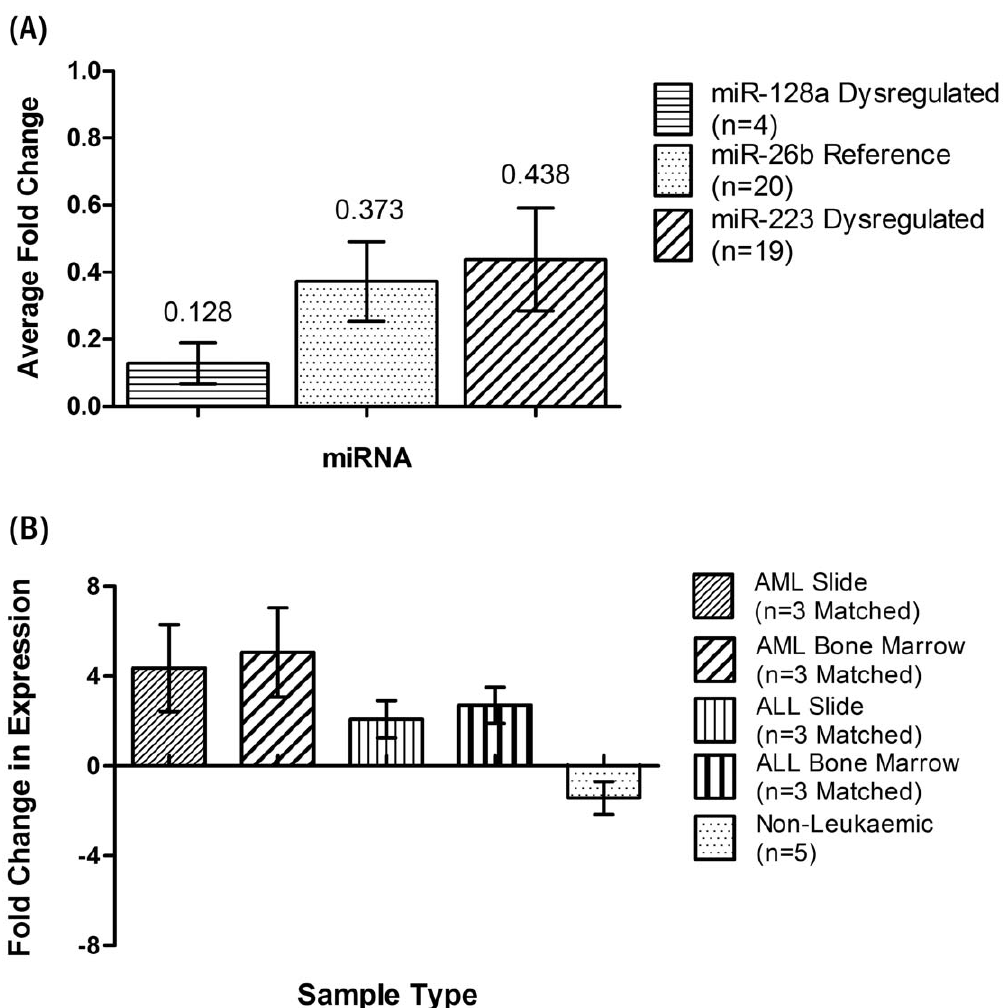
Figure 3. The average fold change in miRNA expression between matched patient fresh bone marrow aspirates and archived bone marrow slides. The average fold change in miRNA expression between matching time-point patient fresh bone marrow aspirates and archived slide bone marrow aspirates (Table S4). ( A ) microRNA expression of matched patient fresh bone marrow and archived slide samples . Three miRNA TaqMan assays were used (hsa-miR-128a, hsa-miR-26b, hsa-miR-223) and the Livak method for Fold Change analysis [34] to analyse the fold change difference between fresh Bone marrow and matching archived slides. hsa-miR-128a and hsa-miR-223 have been previously reported to have altered expression in leukaemia, whereas we have found here hsa-miR-26b is a stable reference. The overall difference in miRNA expression between fresh bone marrow samples and their matching archived slide as shown here is negligible. ( B ) Difference in hsa-miR-223 expression in archived and fresh leukaemic samples . Previously reported dysregulated miRNA hsa-miR-223 was used to analyse the fold change difference between leukaemic and non-leukaemic samples, to gauge the biological relevance of archived specimens in comparison to fresh. All samples were normalized to hsa-miR-26b. AML and ALL both showed fold change differences of hsa-miR-223 compared to non-leukaemic samples. The bone marrow and archived slides showed similar expression in both AML (Bone Marrow: 5.1 6 1.99 s.e.m.; Slide: 4.4 6 1.94 s.e.m.) and ALL (Bone Marrow: 2.71 6 0.81 s.e.m.; Slide: 2.1 6 0.83